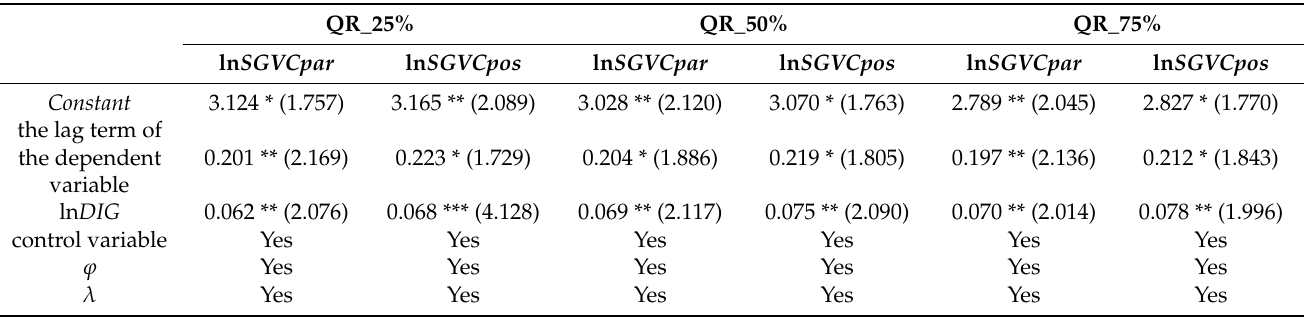
Table 4. Results of robustness test